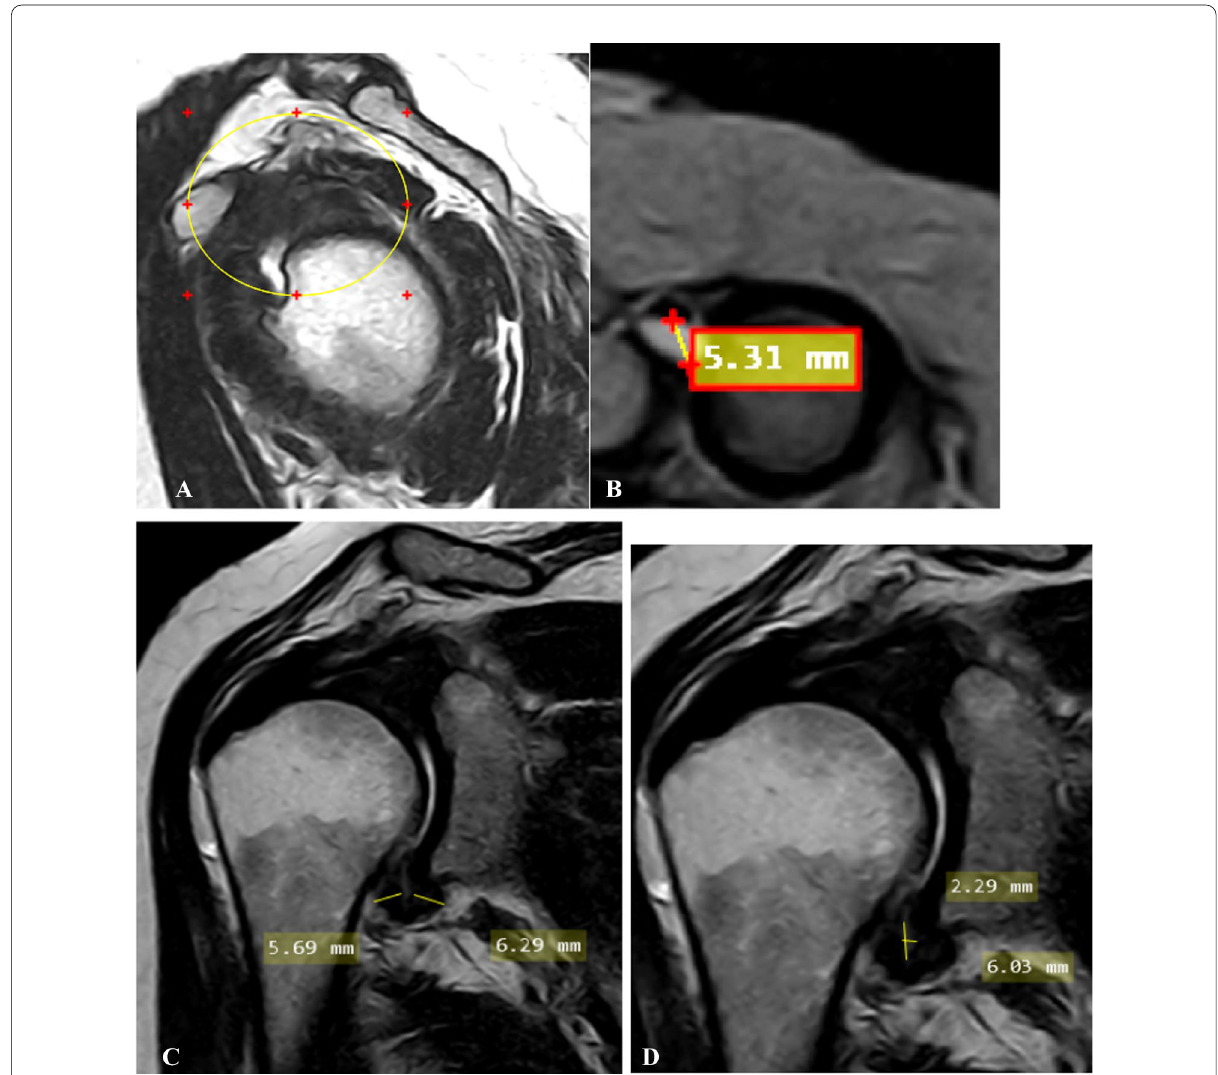
Fig. 2 A Oblique sagittal T2-weighted MRI image shows complete obliteration of subcoracoid fat triangle (encircled area). B Oblique axial fat- suppressed PD weighted MRI image shows effusion at long head biceps tendon sheath more than 2mm. C Oblique coronal T2-weighted MR image shows measurement of thickest portion of joint capsule in humeral and glenoid portions of axillary recess. D Oblique coronal T2-weighted MR image shows measurement of maximal height and width of axillary